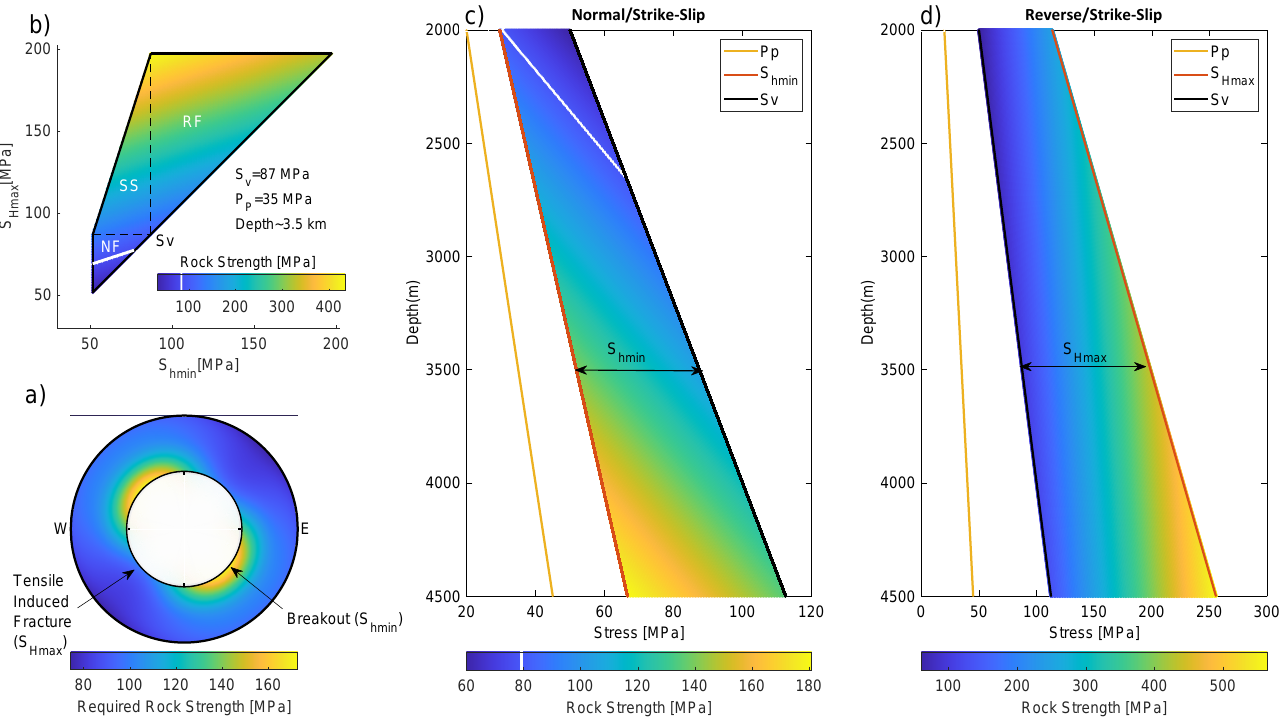
Figure 4. ( a ) example of stress concentration around a vertical borehole and the location of borehole breakout and tensile induced fracture and their relation to principal stress orientations; ( b ) range of possible stress magnitudes (stress polygon) for horizontal principal stress at a depth of 3.5 km where Pp = 35 MPa, and S V = 87.5 MPa; ( c , d ) rock strength required to initiate a breakout in normal and reverse faulting regimes in the Sarvak and Asmari Formations of the Dezful Embayment, assuming that the stresses at the limit are constrained by a friction coefficient where µ = 0.6, Pp = 10 MPa/km, and S V = 25